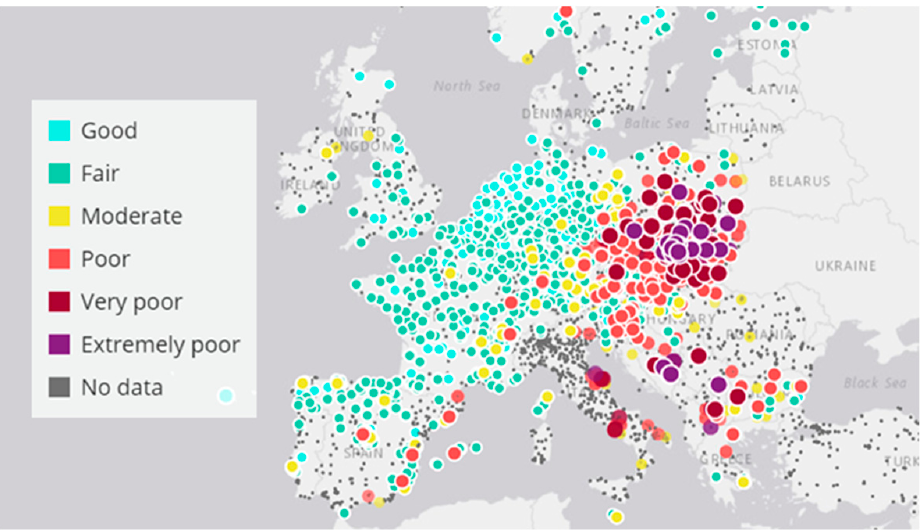
Figure 1. Low air quality index in Poland—carbon-based heating and power (source: [8]). Furthermore, large-scale power stations are heavily regulated, also from the environ- mental point of view. Even if they emit significant amounts of CO 2 and other greenhouse gases (GHGs) (as in case of hard or lignite powered ones) which impact the climate, it is much easier to control the emissions of harmful substances to human beings through regu- latory decisions. Taking into account the above, it is clear that heat pumps have a significant potential to improve the local air quality. However, to consider them as a clean energy source, one has to take a detailed look at the country-specific CO 2 emissions associated with each kWh of electricity generated. This is of particular importance in countries such as Poland in which the process of decarbonizing the power system is still in the early stages and, therefore, the majority of electricity comes from combustion of fossil fuels, as shown in Figure 2. In summary, it is obvious that despite heat pumps’ ability to convert electricity into useful heat with high efficiency, the heat they generate has some associated emissions linked directly to the power system